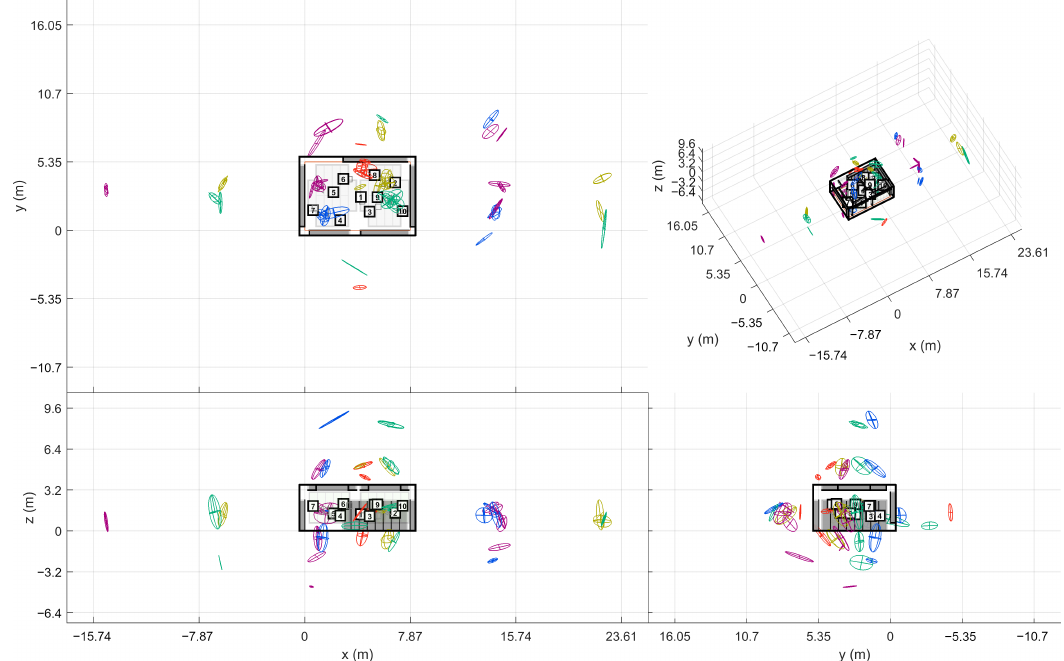
Figure A4. Found image sources in variable acoustics room Arni when acoustic panels on the -y wall are open (min. 3 ER objects per image source). The number of image sources are greatly reduced on the -y